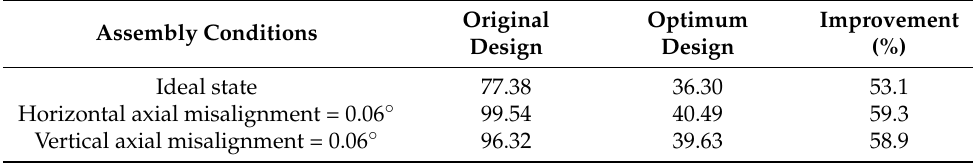
Figure 12. RMS of acceleration signal: ( a ) ideal state; ( b ) horizontal axial misalignment; ( c ) vertical axial misalignment. Table 6. RMS of acceleration at natural frequency. (Unit: m/s 2 ). Table 6. RMS of acceleration at natural frequency. (Unit: m/s 2 ).